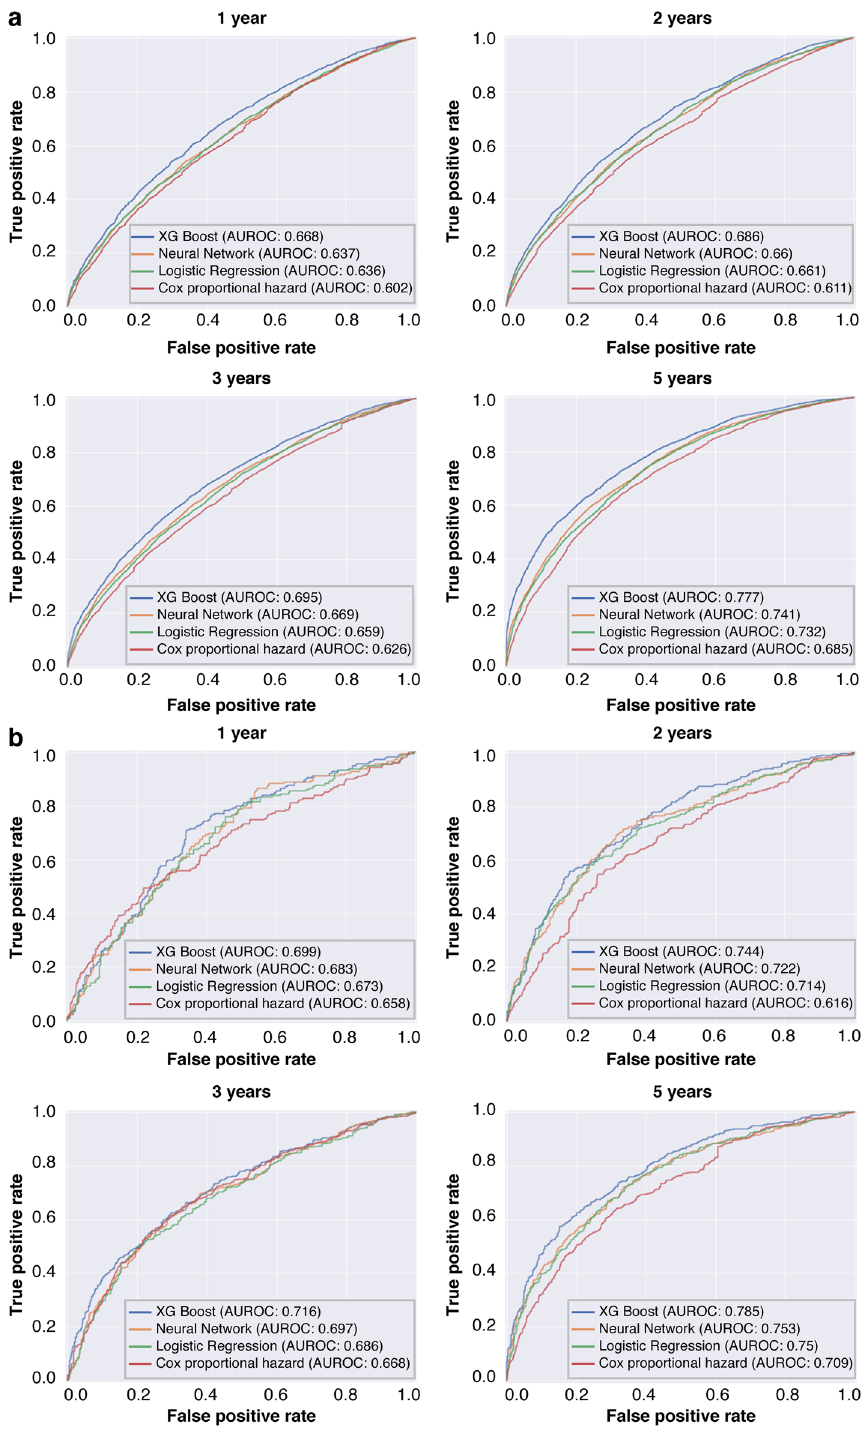
Figure 3. Performance of full prediction models with top 60 variables and 16 laboratory values. ( a ) Diagnosis of CKD/HF and ( b ) hospitalizations for CKD/HF. AUROC area under the receiver operating characteristic curve, CKD chronic kidney disease, HF heart